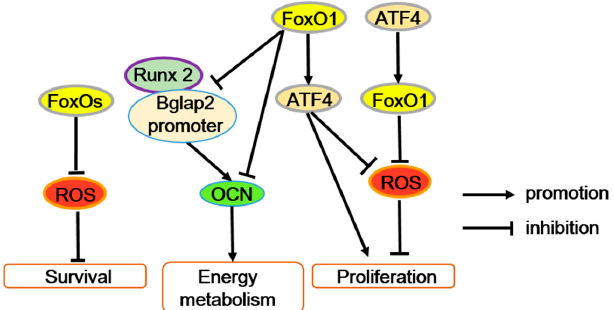
Figure 3. FoxOs’ function in osteoblasts. FoxOs’ transcriptional activity reduces ROS levels